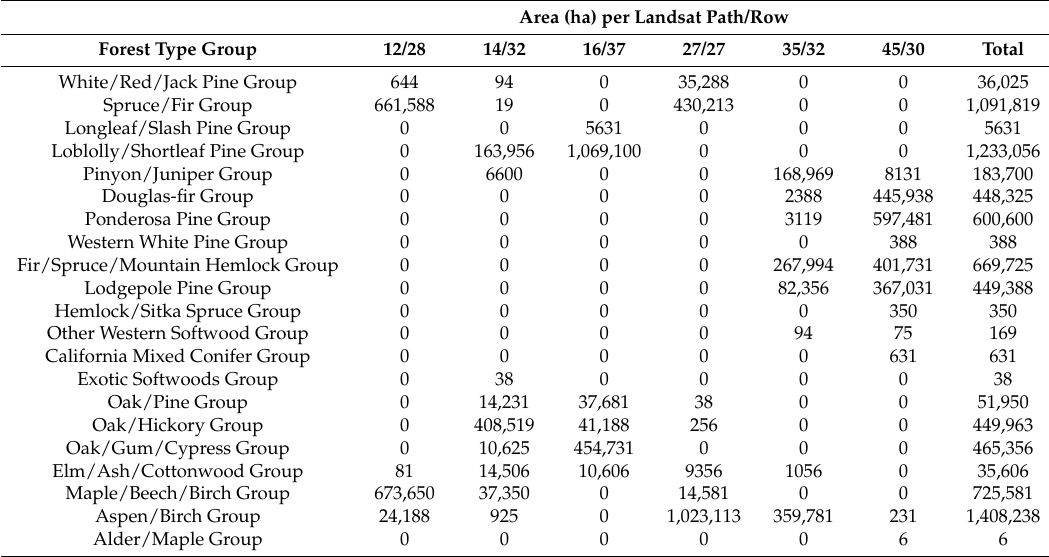
Table 2. Area of forest type groups in each Landsat scene (Path/Row). Data from